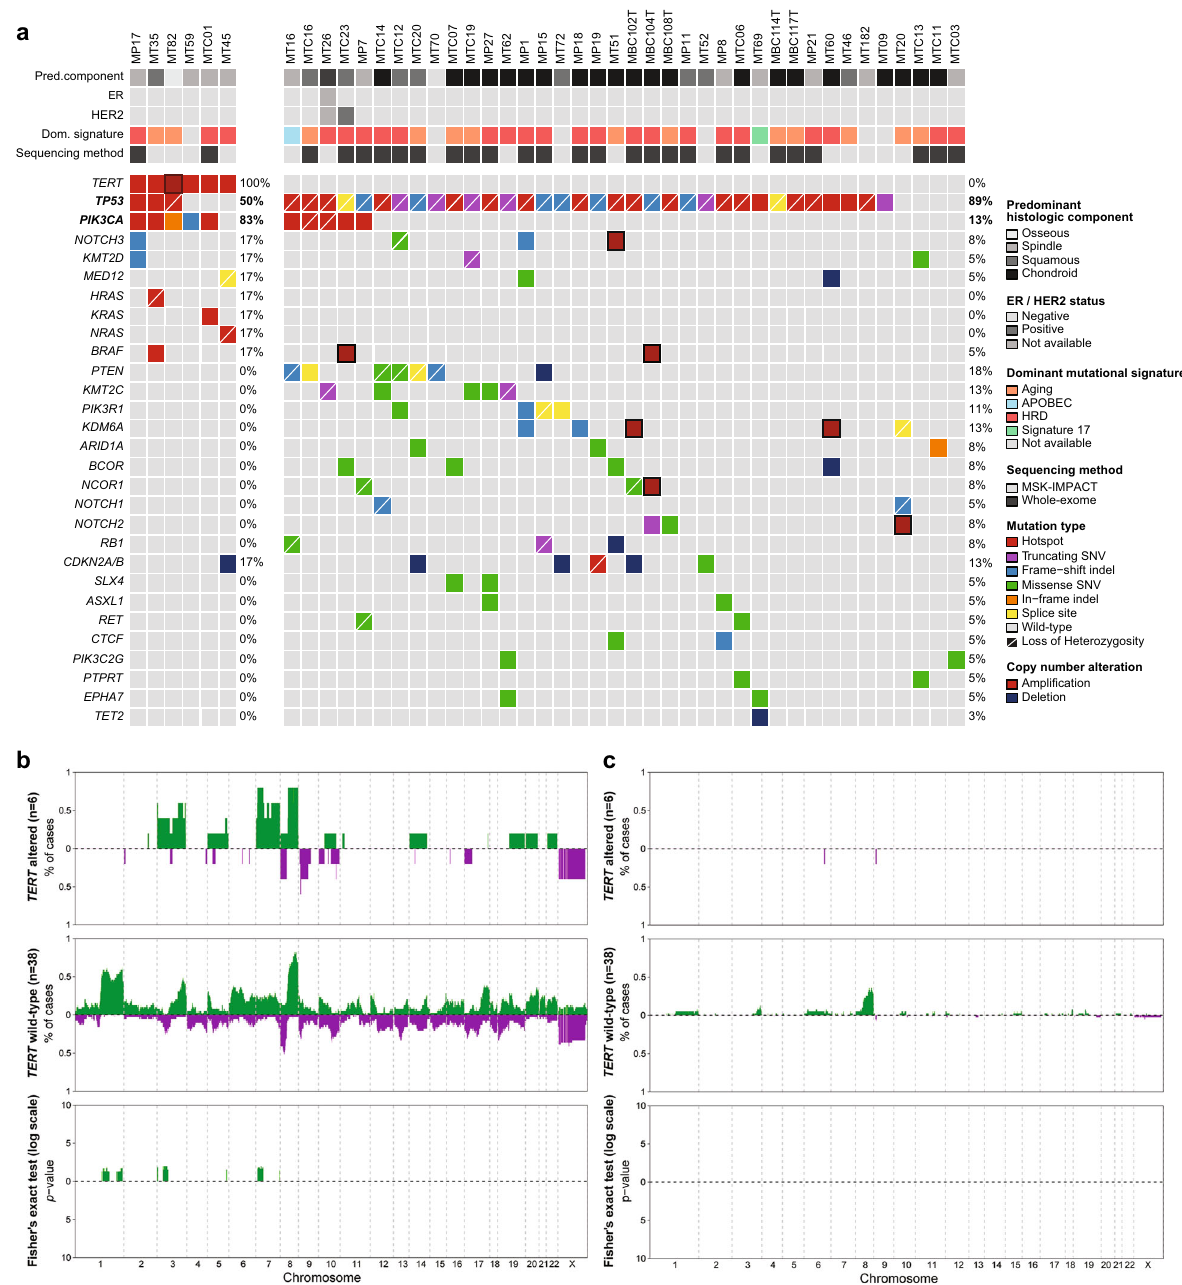
Fig. 3 Repertoire of non-synonymous somatic mutations identi fi ed in metaplastic breast cancers. a Comparison of the most frequent genetic alterations affecting cancer genes identi fi ed in metaplastic breast cancers harboring TERT genetic alterations ( TERT promoter hotspot mutations, n = 5; TERT gene ampli fi cation, n = 1; left) and TERT wild-type ( n = 38, right), by whole-exome sequencing or MSK-IMPACT targeted sequencing. Cases are shown in columns and genes in rows. Clinicopathologic characteristics are shown on the top. Mutations are color coded according to the legend. Frequency plots and Fisher ’ s exact test comparison corrected for multiple testing of ( b ) copy number gains and losses, and ( c ) ampli fi cations and homozygous deletions between TERT altered ( n = 6) and TERT promoter wild-type (n = 38) MBCs. Frequency (y-axis) of gains and losses and ampli fi cations and homozygous deletions is shown for each genomic region (x-axis). Inverse Log 10 values of the two-sided Fisher ’ s exact test p-values are plotted according to the genomic region (lower panel). Gains and ampli fi cations are colored in green. Losses and homozygous deletions are colored in purple. *Statistical signi fi cance was evaluated by the Fisher ’ s exact test ( p < 0.05). **Mutual exclusivity analysis was performed using combinations of mutually exclusive alterations (CoMEt, p < 0.01). HRD, homologous recombination DNA repair defect; SNV, single nucleotide remodeling genes ( ARID1A , KMT2C ) and tumor suppressor genes harboring TERT promoter hotspot mutations, including hotspot ( RB1 , NOTCH1 , and NOTCH2 ) were only identi fi ed in MBCs lacking mutations affecting KRAS (MTC01, subclonal A59G, n = 1), NRAS TERT genetic alterations (Fig. 3a). In addition, activating mutations (MT45, clonal Q61L, n = 1) and HRAS Q61R (MT35, clonal, n = 1), affecting Ras pathway genes were detected in three MBCs which coexisted with mutations affecting TP53 (subclonal V173L